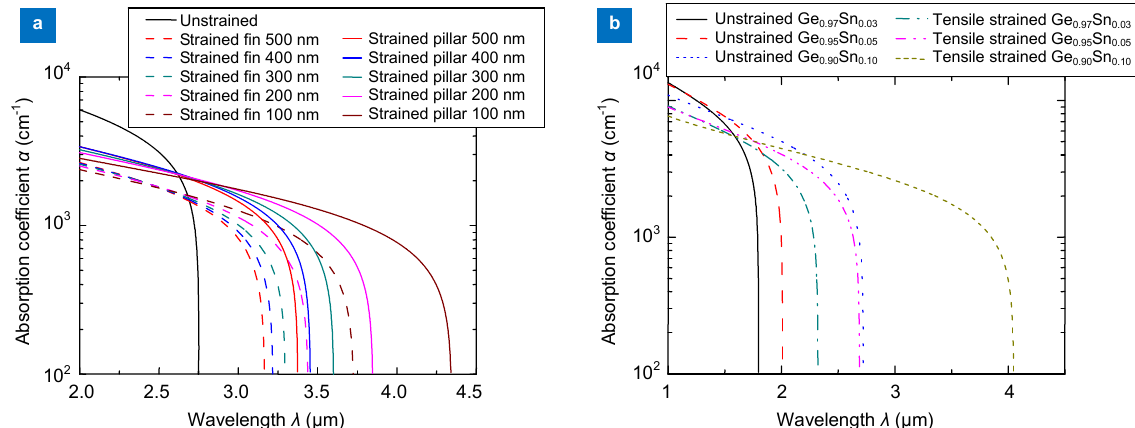
Fig. 3 | ( a ) Comparisons of the absorption spectra of relaxed and strained GeSn in fin and pillar array detectors at the Sn content of 0.1. L pillar and T fin feature size varys from 100 nm to 500 nm in a step of 100 nm. ( b ) Calculated absorption spectra for relaxed and tensile strained GeSn waveguide photodetectors at different Sn content. Figure reproduced from: ( a ) ref. 33 , IEEE; ( b ) ref. 26 , Optical Society of America.